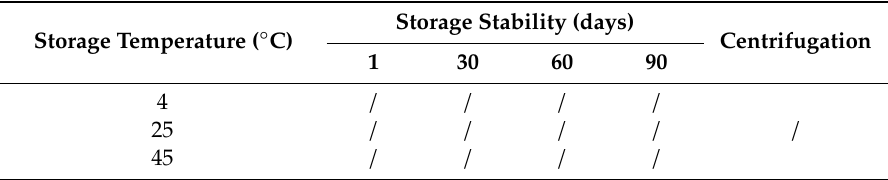
Table 7. Physical stability of optimized nanoemulsion containing KMO under di ff erent storage temperatures (4, 25 and 45 ◦ C) and centrifugation